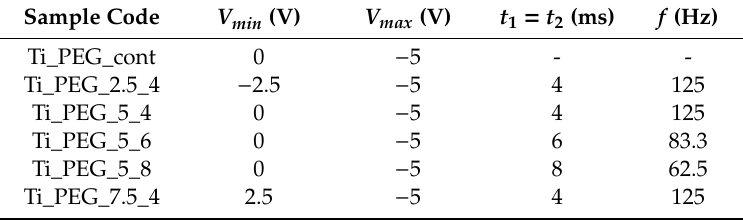
Table 1. Conditions used for the electrodeposition of the titanium samples. V min is the voltage applied during t 1 , V max is the maximum voltage applied during t 2 . Pulsed samples are coded as Ti_PEG_ ∆ V_T, where ∆ V stands for the potential di ff erence and T stands for the period of the wave ( t 1 + t 2 ). Sample Code V min (V) V max